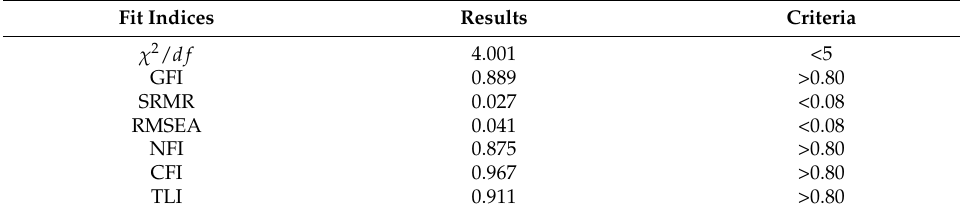
Table 5. Results of goodness-of-fit for SEM.